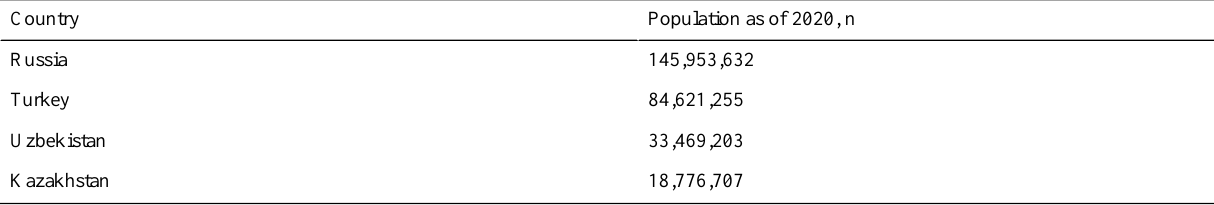
Table 7. Most populous countries in Central Asia as of